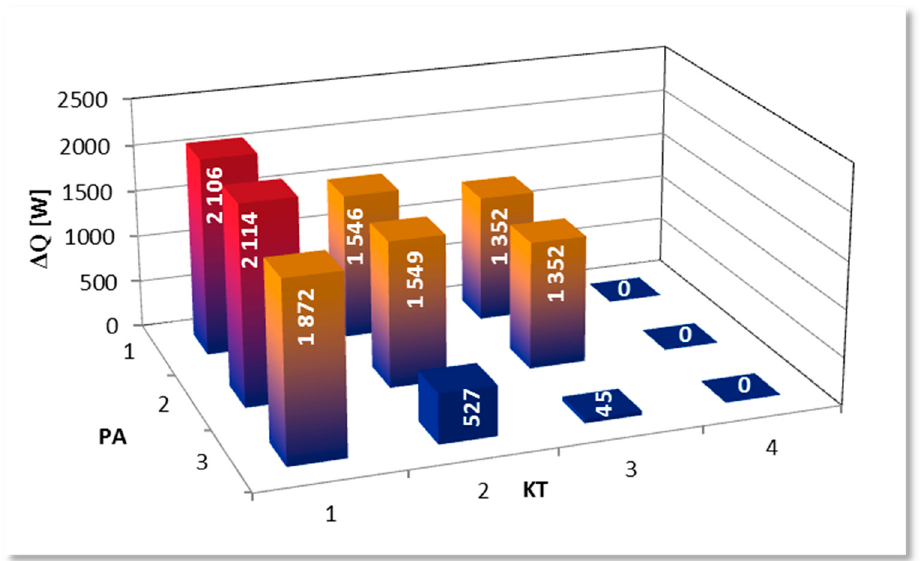
Figure 12. The e ff ect of PA and KT on the increase in the heat transfer e ffi ciency of the evaporator (n = Figure 12. The effect of PA and KT on the increase in the heat transfer efficiency of the evaporator (n 0.8, m = 8 kg / = 0.8, m = 8 kg/s).